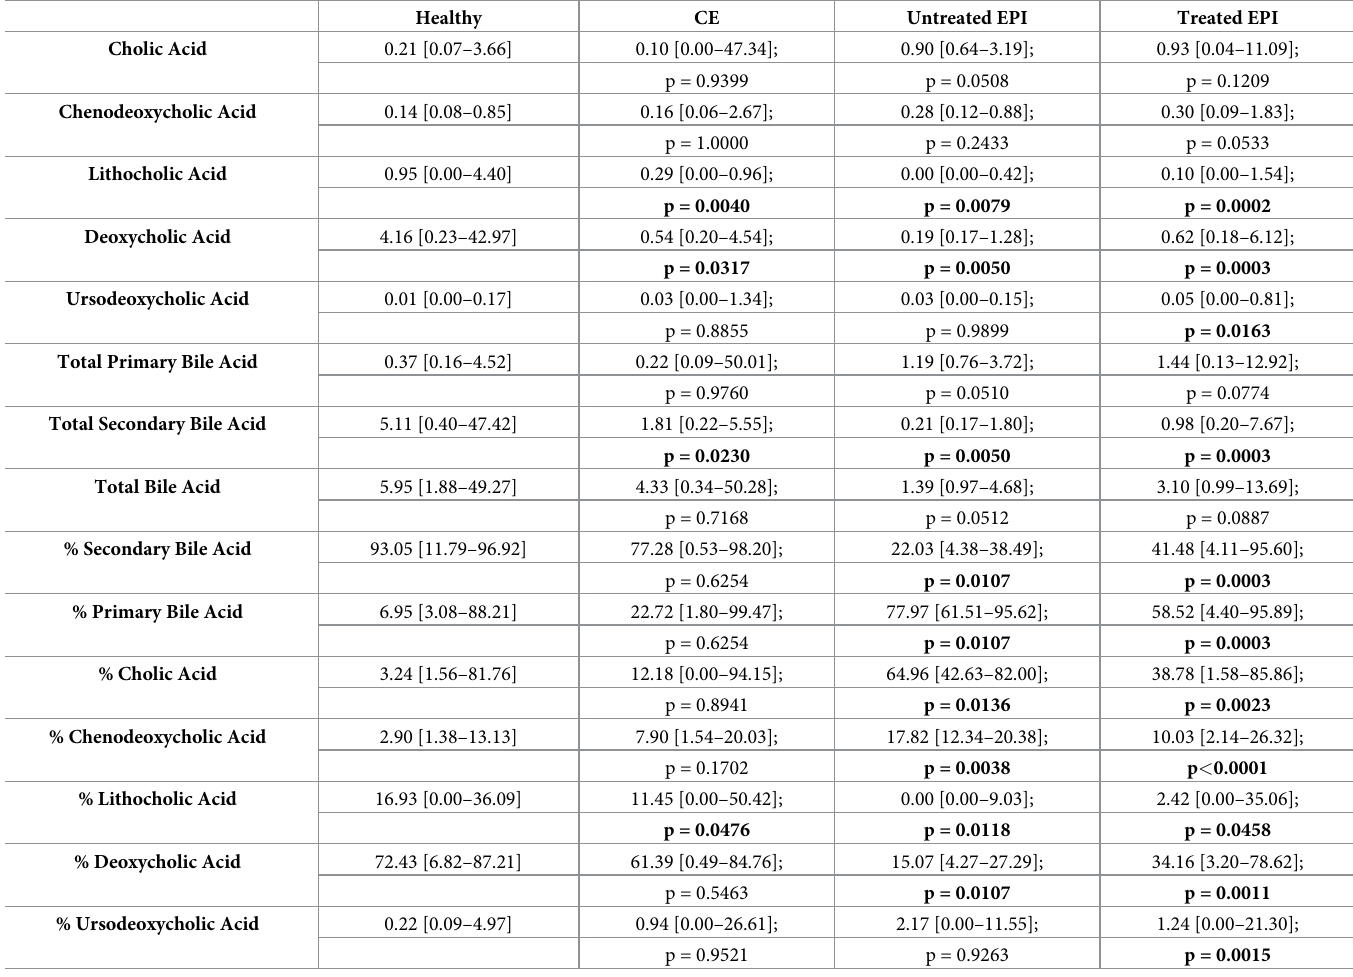
Table 4. Bile acid concentrations (median [min-max] μ g/mg lyophilized feces) and bile acid proportions (median [min-max] % of total bile acids) in diseased dogs compared to healthy control dogs with Steel-Dwass